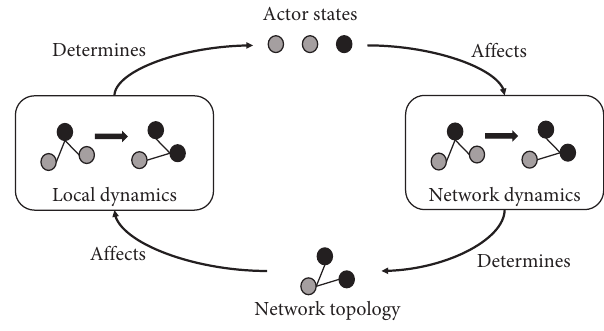
Figure 1: Logic of coevolving